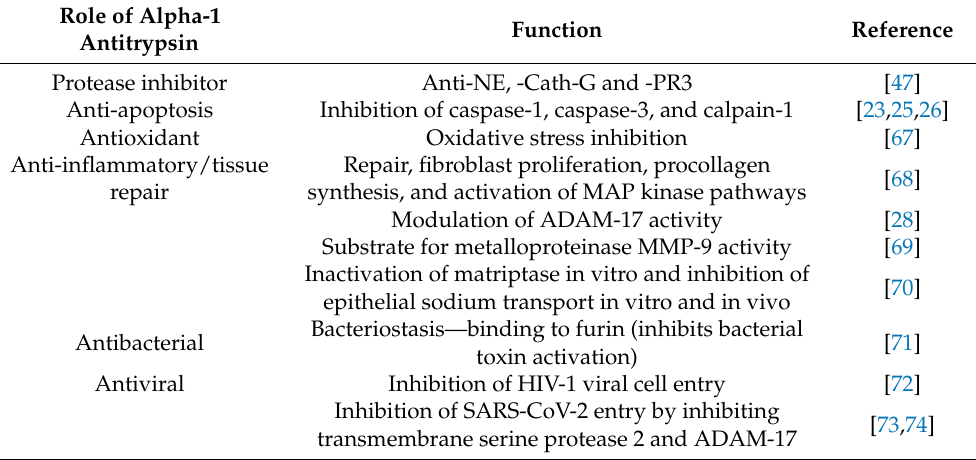
Table 2. Pleiotropic functions of alpha-1